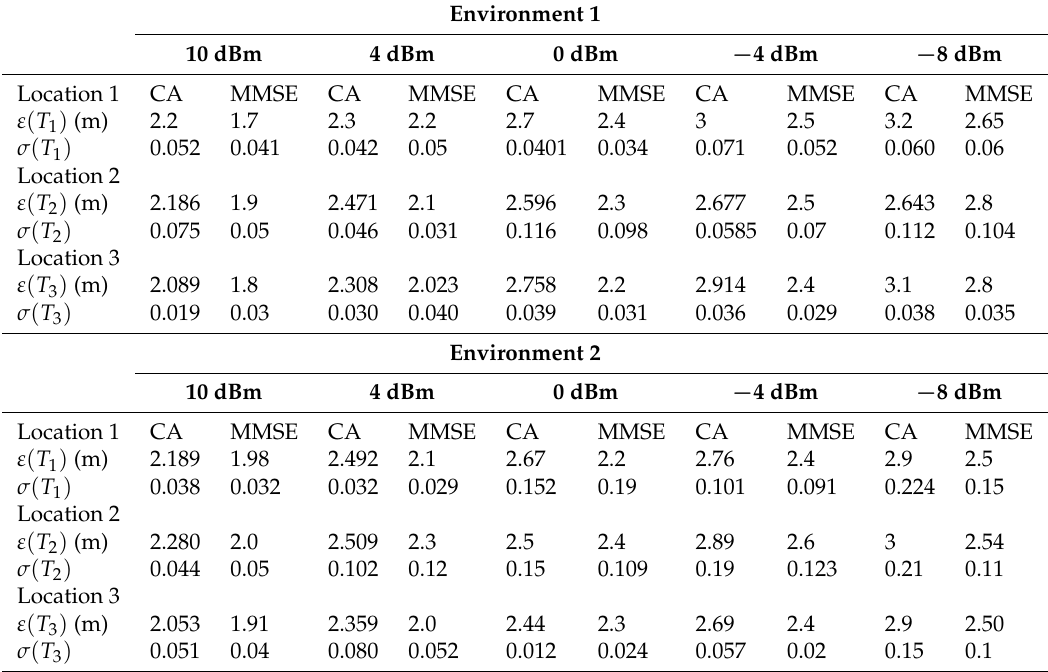
Table 8. Localization Accuracy and Localization Precision by using KF at 3 Tag Locations in Environment 1 and Environment